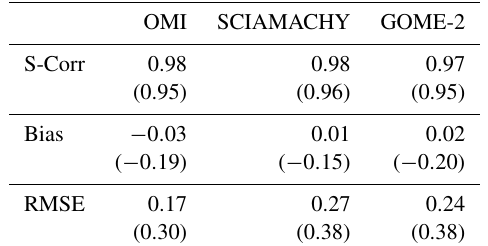
Table 3. Comparisons of global tropospheric NO 2 columns be- tween the control run and the satellite retrievals in brackets and be- tween the reanalysis run and the satellite retrievals: OMI for 2005– 2018, SCIAMACHY for 2005–2011, and GOME-2 for 2007–2018. Shown are the global spatial correlation (S-Corr), the mean bias (Bias: the data assimilation minus the satellite retrievals), and the root-mean-square error (RMSE) in 10 15 molec . cm − 2